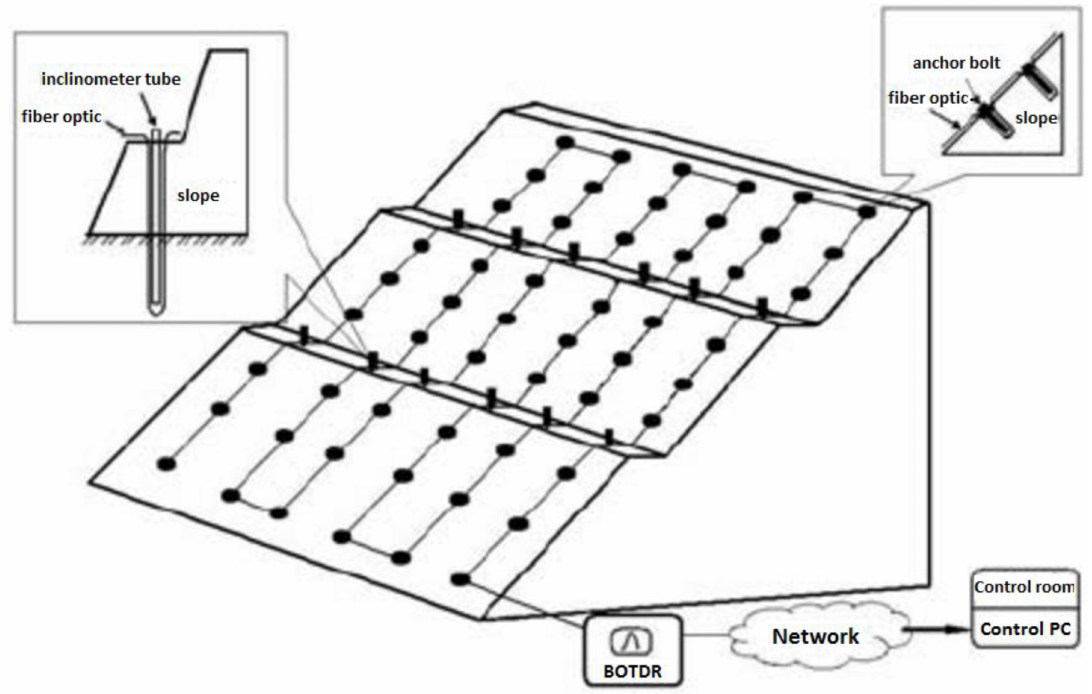
Figure 17. Example of optical fibre cable deployment for slope monitoring using a BOTDR interrogator. After